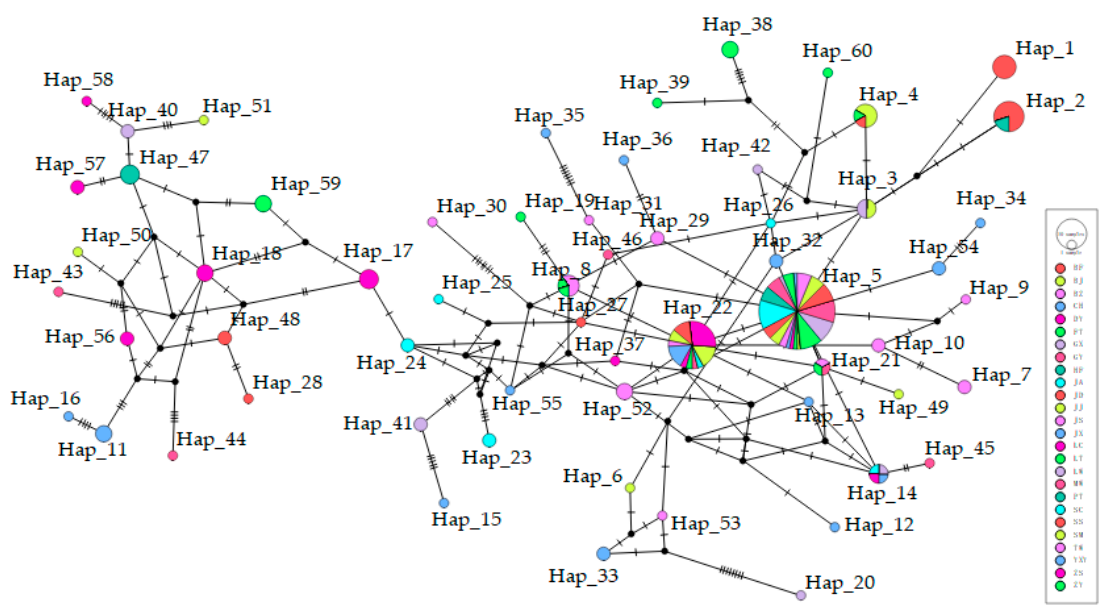
Figure 4. Phylogenetic tree based on mtDNA control region sequences for the 26 duck populations.